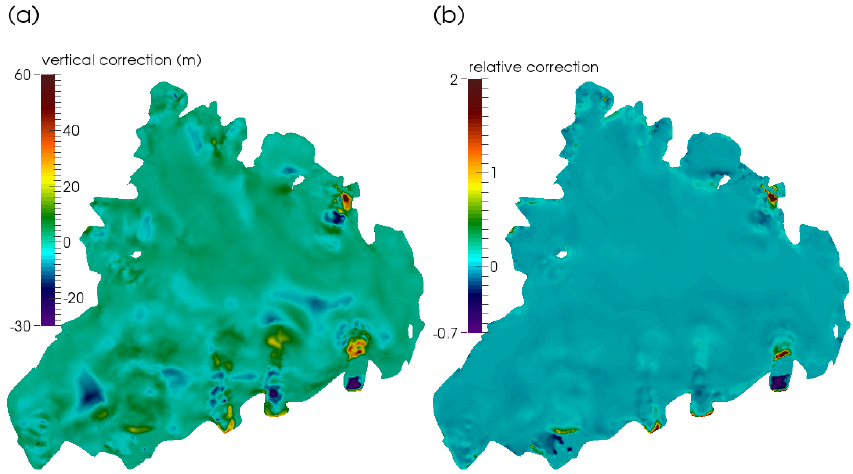
Figure 5. Vertical corrections (in metres) of the topographic data (1995 basal friction parameter field) at the end of the surface relaxation (simulation surfrelax95 ): (a) absolute corrections, (b) relative to the initial ice